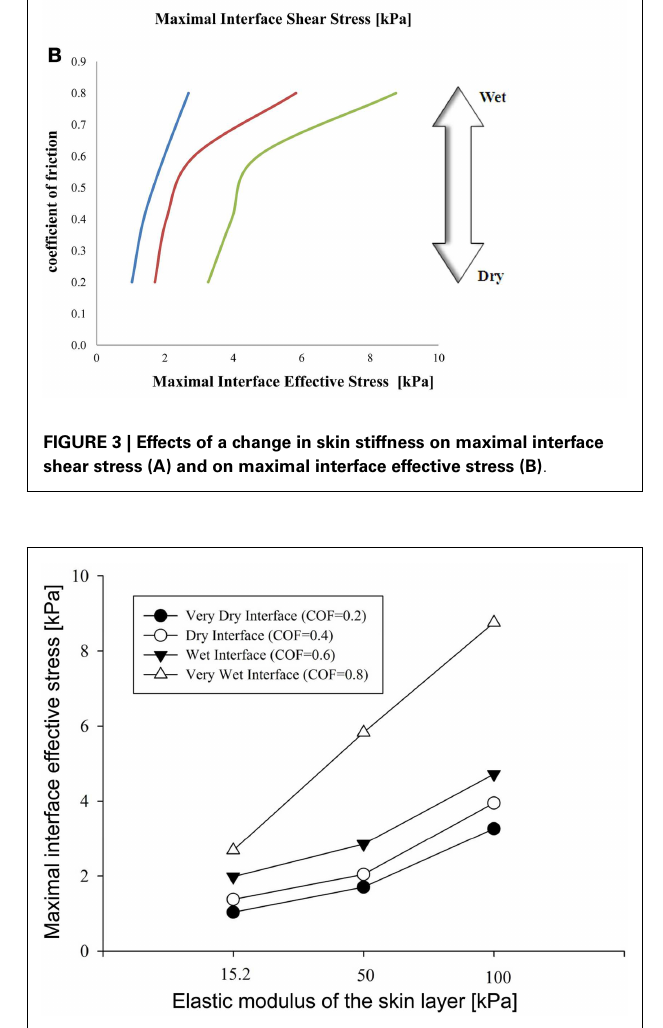
FIGURE 4 | Results of the factorial analysis: the influence of dry versus wet interface on maximal interface shear stress .